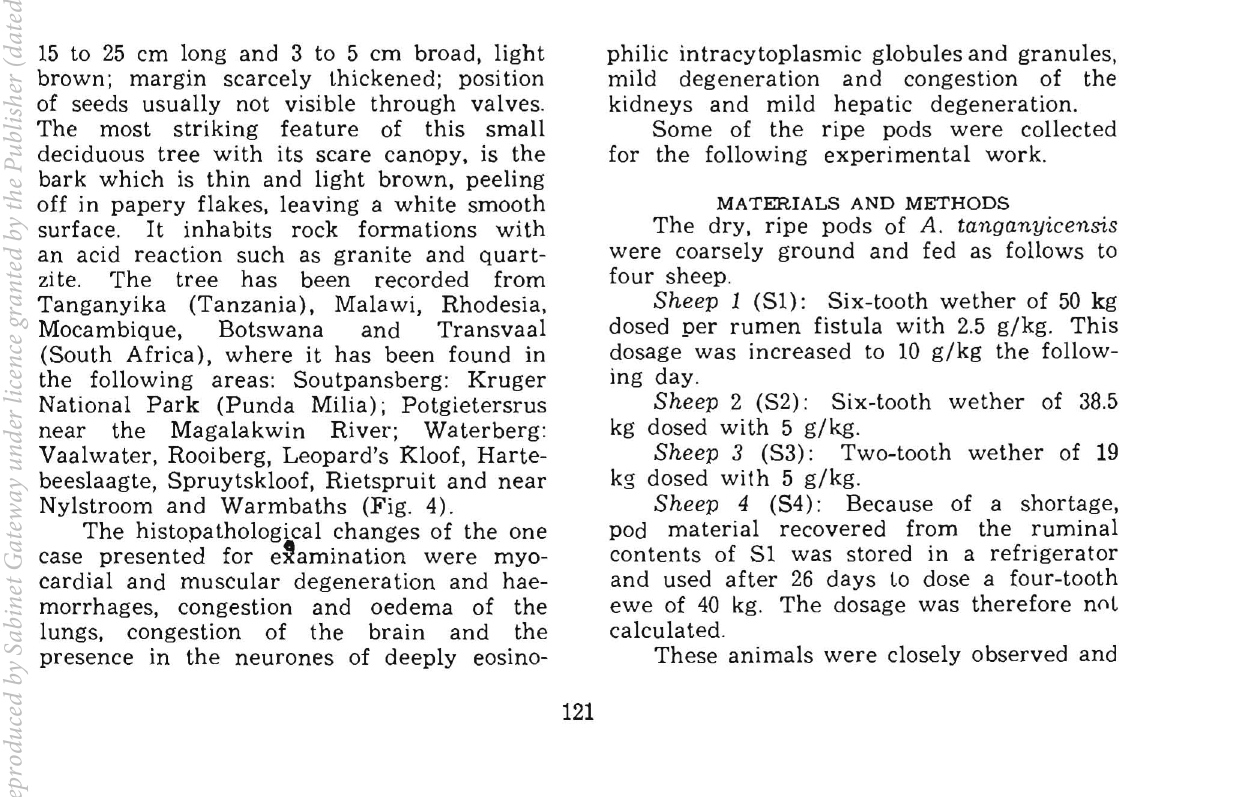
FIG. 2. Pods of A.